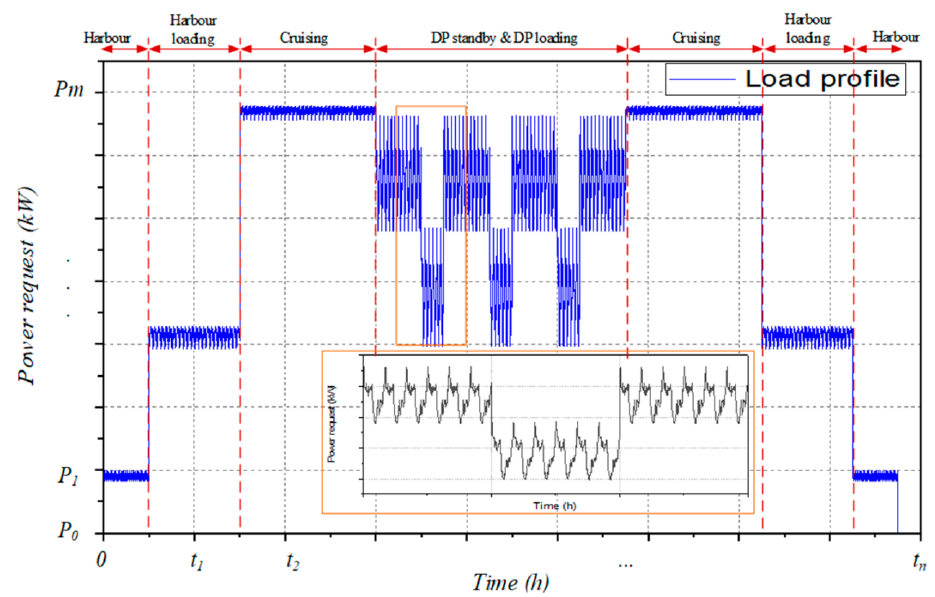
Figure 7. A representative load profile of a DP vessel.